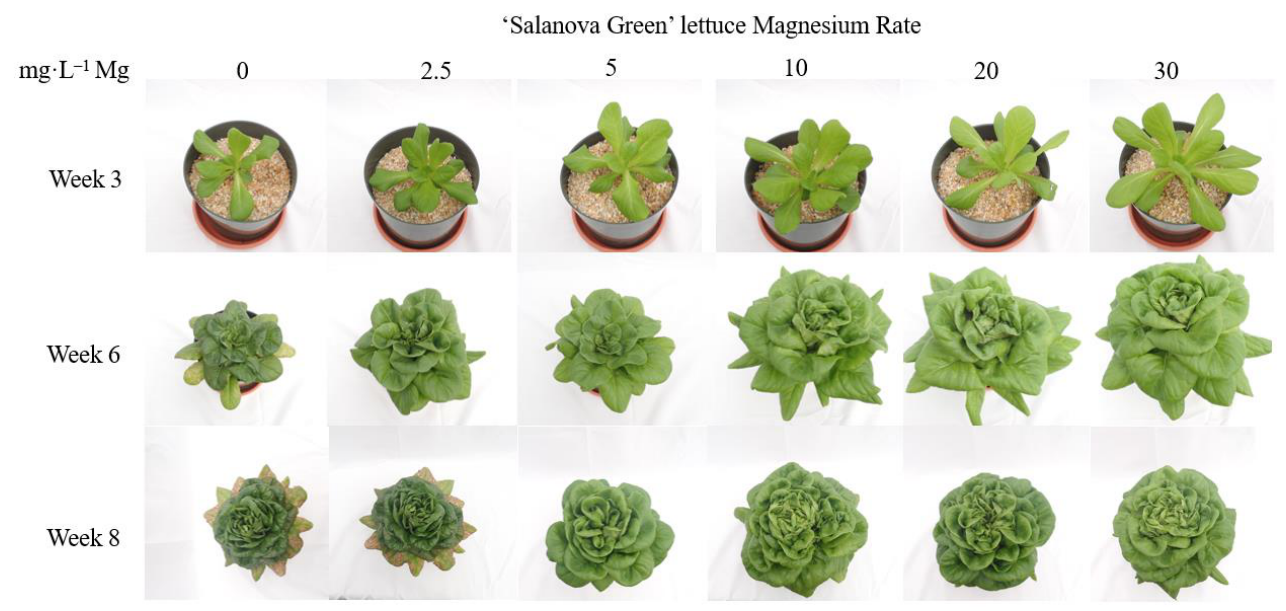
Figure 6. Visual impact of magnesium (Mg) fertility rate on Lactuca sativa ‘Salanova Green’ at Weeks 3, 6, and 8.